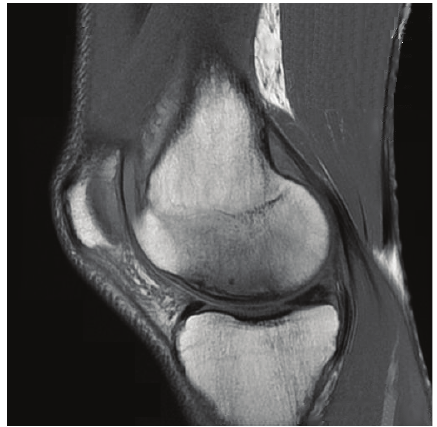
Figure 1: MRI of right knee demonstrating flattening and irregular- ity of the articular surface with small cyst formation and alteration of the marrow signal, which suggests